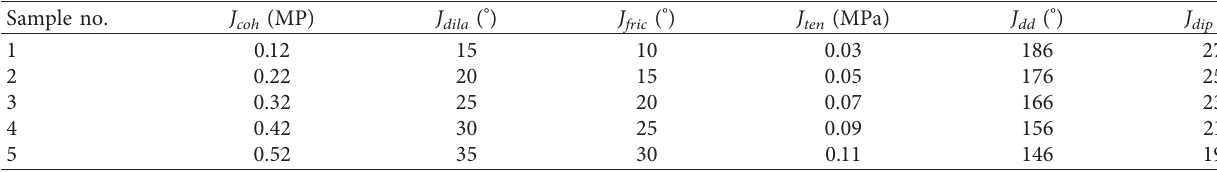
Figure 3: Numerical calculation model of metro station. (a) The calculation model. (b) Layout of monitoring points. Table 1: Range of joint parameters.